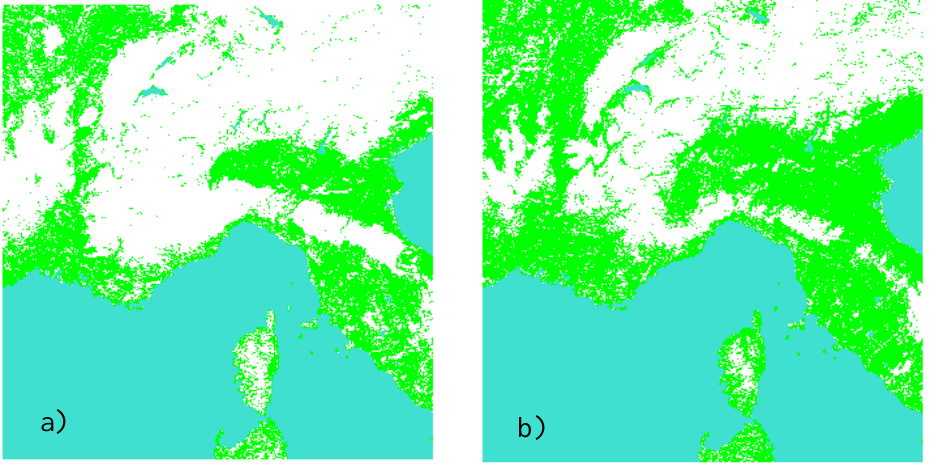
Figure 4. MODIS derived maximum snow cover extent during December 2008 (a) and December 2003 (b). Snow covered areas are colored in white, snow-free areas in green, and water surfaces in